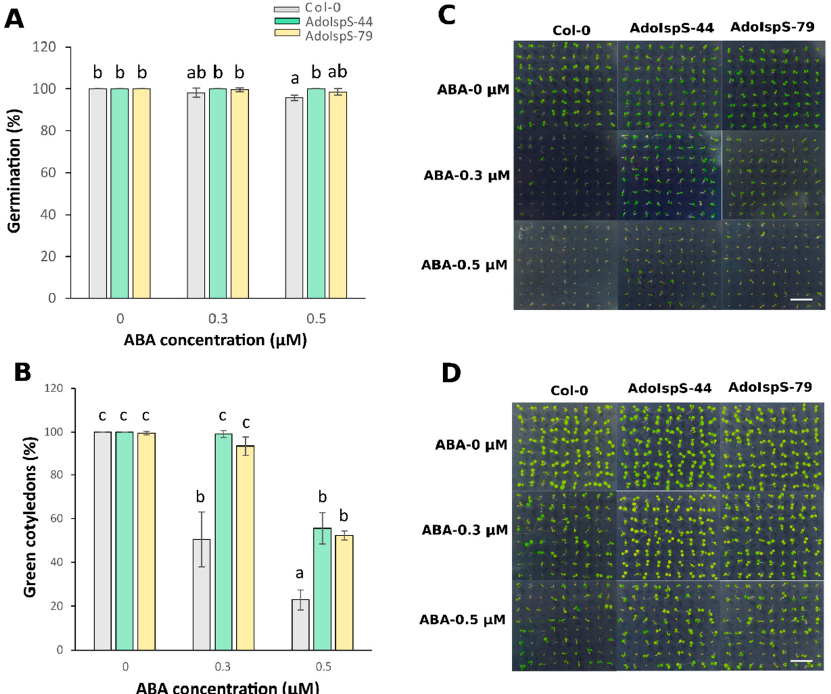
Figure1. E ff ectofABAongerminationoftransgeniclinesoverexpressingthe IspS gene. ( A )Germination rates of Col-0 and transgenic plants treated with di ff erent concentrations of ABA (0 µ M, 0.3 µ M, 0.5 µ M) for 3 days. ( B ) Greening of cotyledons of Col-0 and transgenic plants exposed to di ff erent concentrations of ABA (0 µ M, 0.3 µ M, 0.5 µ M) for 5 days. Histogram bars marked with the same letter do not significantly di ff er from each other (Tukey–Kramer test, p > 0.05). Error bars represent the SD of the means. In ( C , D ), representative pictures of germinating seedlings exposed to di ff erent concentrations of ABA at 3 days and 5 days after sowing are shown. Scale bar = 1